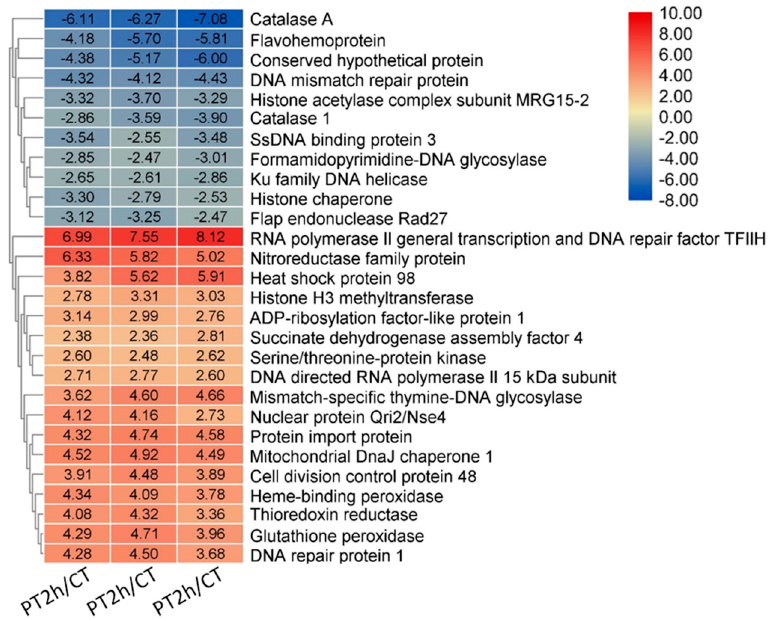
Figure 5. Heat map of di ff erentially expressed genes in the response to stress term in PAE treatment and control groups.